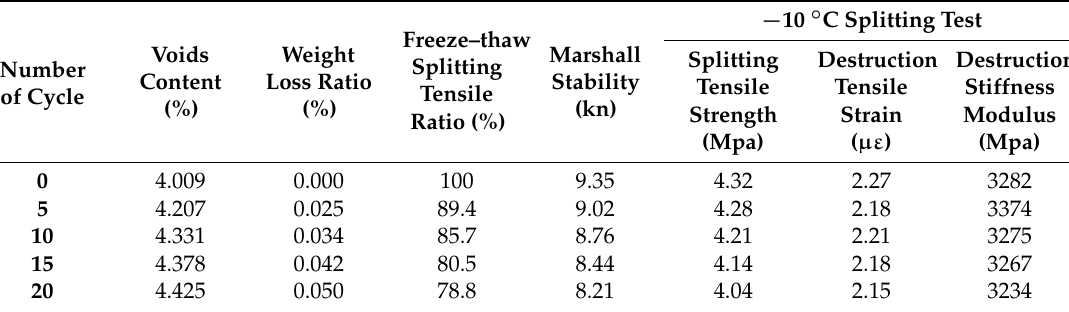
Table 8. Variation of NHSS-AC parameters under freezing cycle.